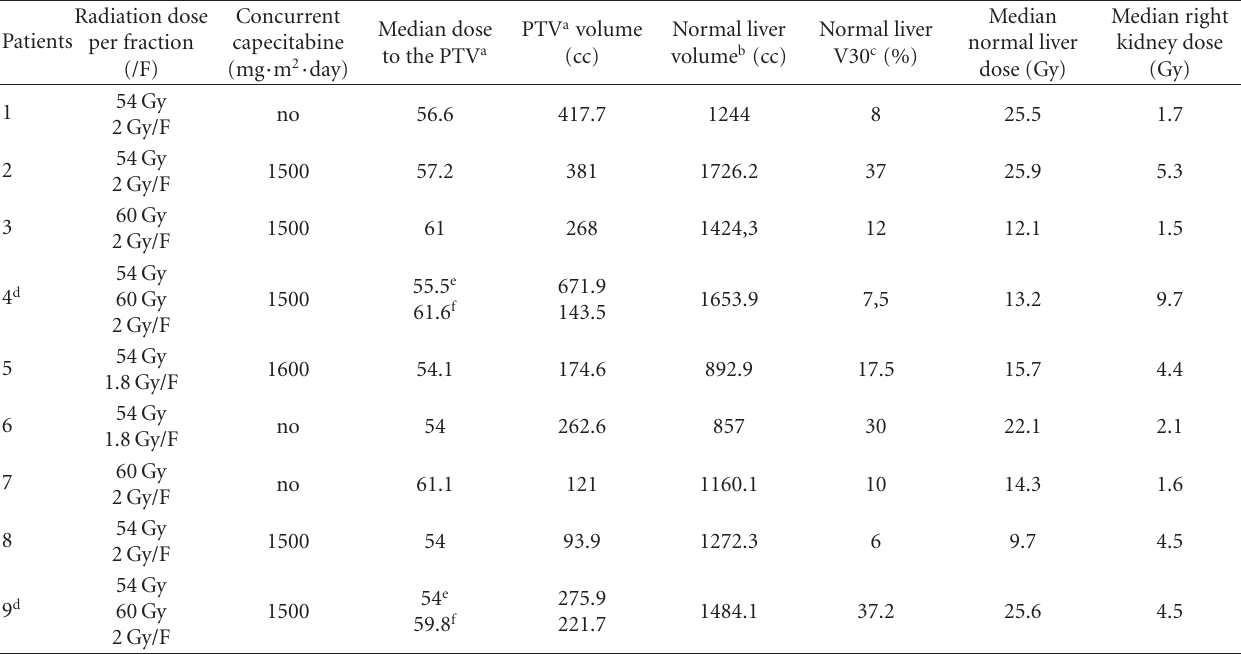
Table 3: Treatment characteristics and dosimetric results.